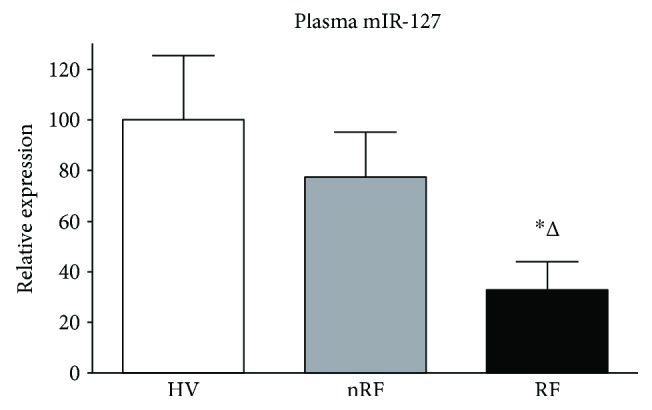
The relative expression of plasma miR-127 in the patients with AP and HVs. The level of miR-127 was expressed as 2−ΔCt (ΔCt = CtmiR-127 − CtmiR-16) using REST 2009 software (Qiagen Inc.). Normalized HV group as 100. ∗P = 0.014 versus HVs; ΔP = 0.043 versus nRF group.